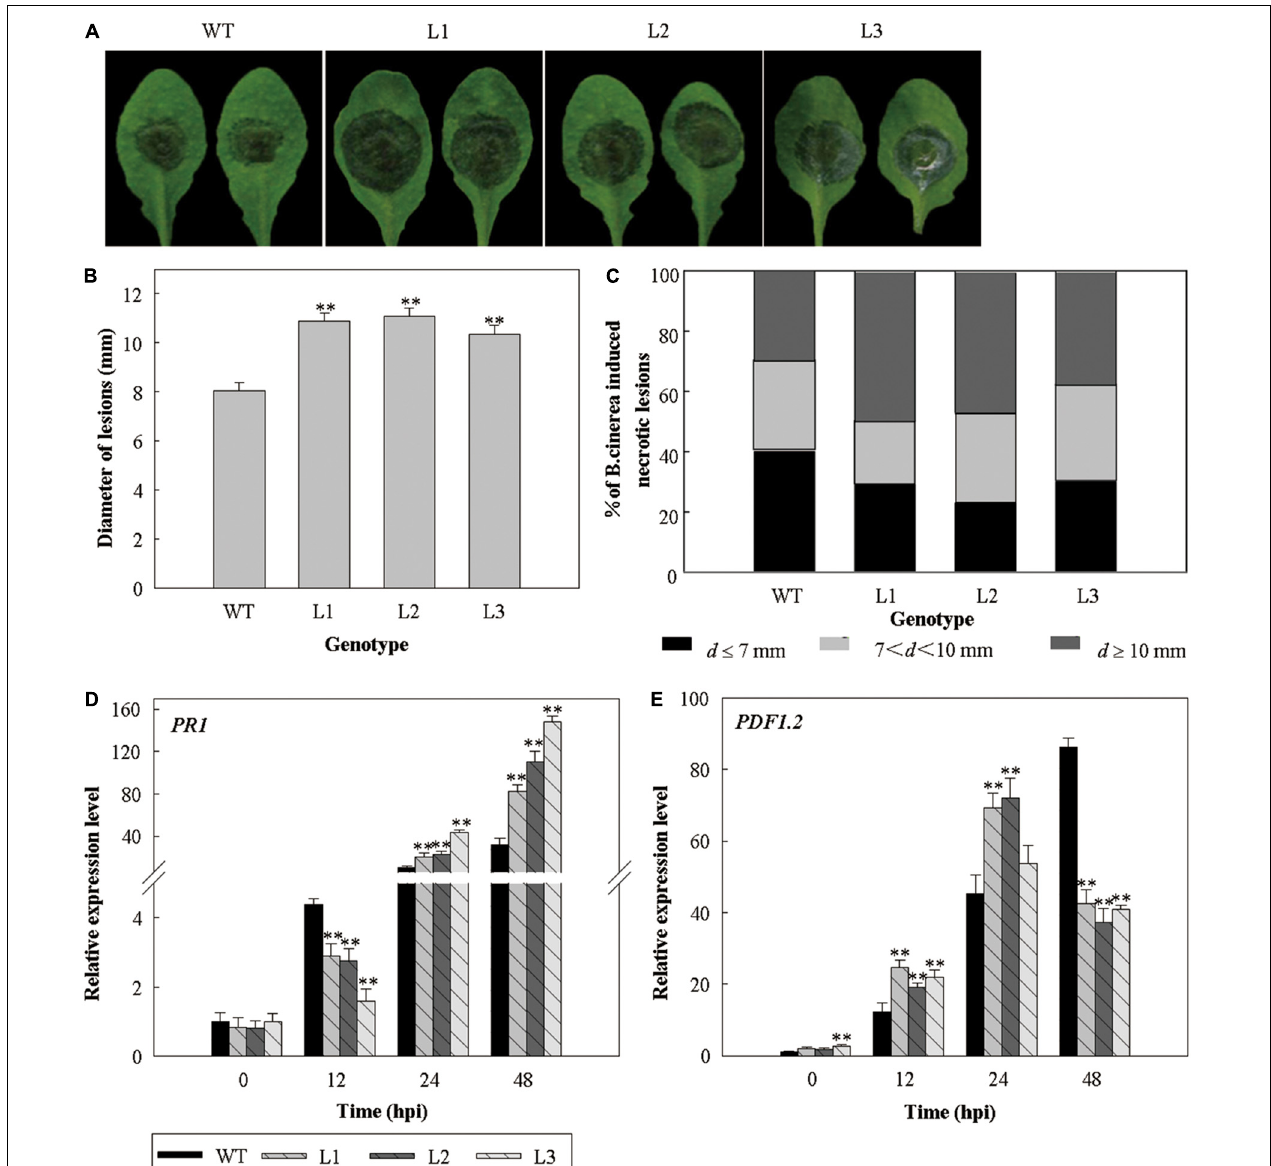
FIGURE 7 | The response of VlWRKY3 over-expressing Arabidopsis thaliana to inoculation with Botrytis cinerea . (A) The phenotypes of transgenic and WT leaves 3 days after inoculation. (B) Average lesion diameters 3 days after inoculation. Data values represent mean ± SD from three independent experiments with at least 50 leaves per sample. Asterisks indicate statistical significance ( ∗∗ P < 0.01, Student’s t -test) between transgenic lines and WT. (C) Symptoms 3 days after inoculation were scored by defining three lesion diameter (d) classes: d ≤ 7 mm; 7 < d < 10 mm; d ≥ 10 mm. Data values represent means from three independent experiments with at least 50 leaves per sample. (D,E) Relative expression levels of PR1 (D) and PDF1.2 (E) Relative gene expression levels were determined using quantitative RT-PCR. Bars represent the mean ± SD of three independent experiments. Asterisks indicate statistical significance ( ∗ 0.01 < P < 0.05, ∗∗ P < 0.01, Student’s t -test) between transgenic lines and